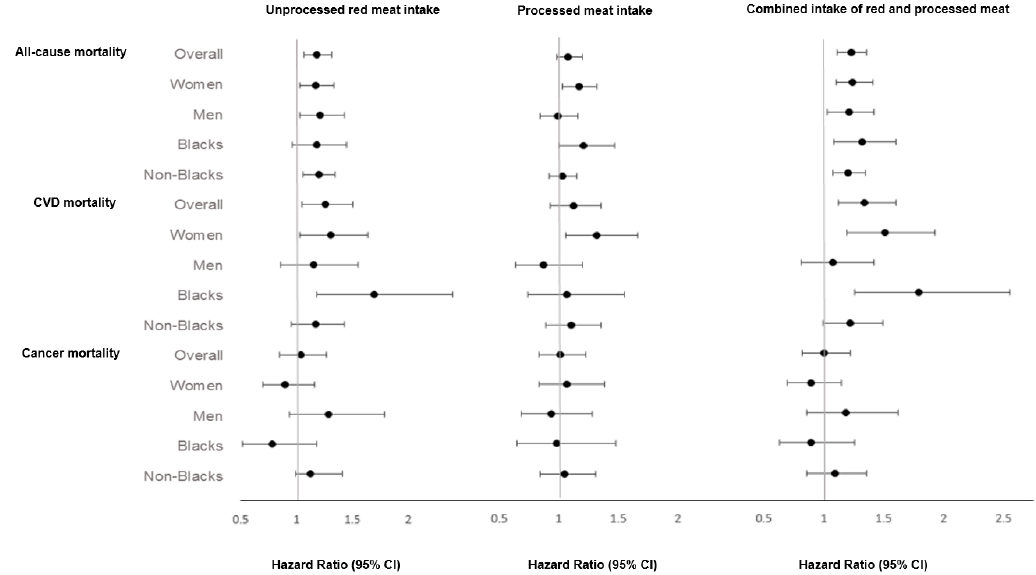
Figure 1. Subgroup analysis by sex and race of the association between red meat and processed meat intake and all-cause, cardiovascular, and cancer mortality. Multivariable hazard ratios for mortality comparing the 90th percentiles (sex- and race-specific values) of unprocessed red and processed meats intakes and both combined with zero-intake (90th vs. 0) were adjusted for age; sex (not in sex subgroup analysis); race (not in race subgroup analysis); marital status; education level; multivitamin use; smoking; alcohol use; exercise; sleeping hours; body mass index (BMI); diabetes mellitus; hypertension; hypercholesterolemia; aspirin use; the use of blood pressure medications for at least 2 years in the last 5 years; the use of statin for at least 2 years in the last 5 years; menopausal status in women and hormone replacement therapy (HRT) among postmenopausal women; dietary energy; and dietary variables including cruciferous vegetables, fruits, whole grain, legumes, nuts and seeds, total dairy, eggs, fish, and unprocessed poultry.